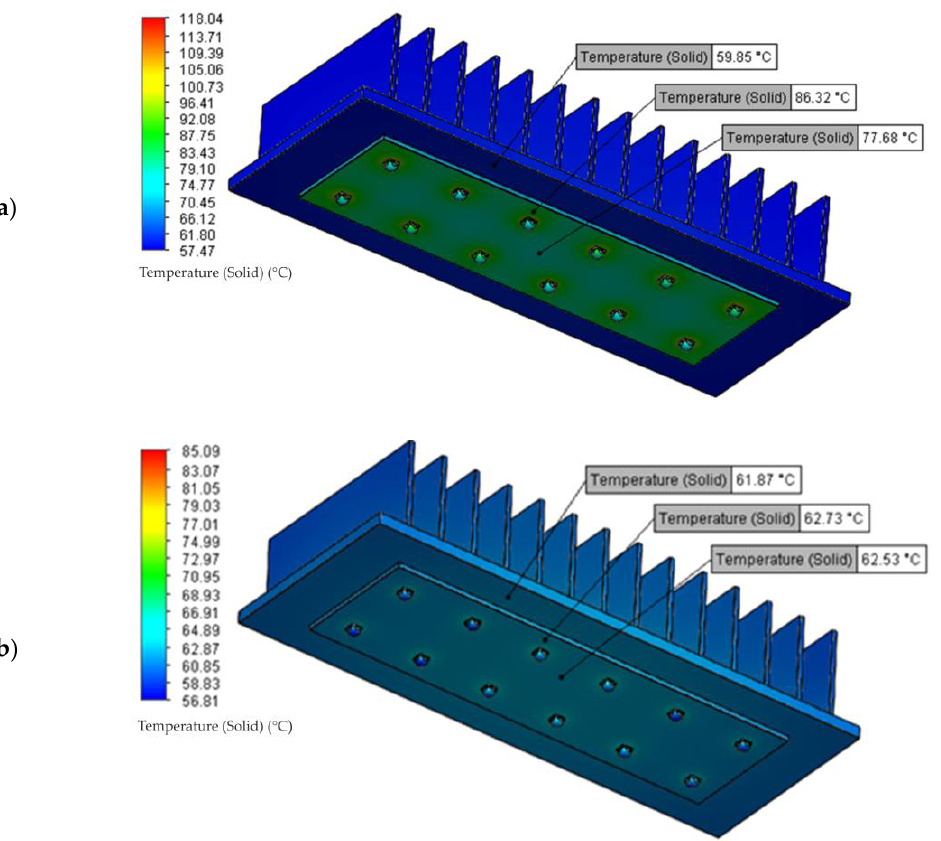
Figure 17. Temperature distribution of the LED panel with a printed circuit: ( a ) PCB and ( b )